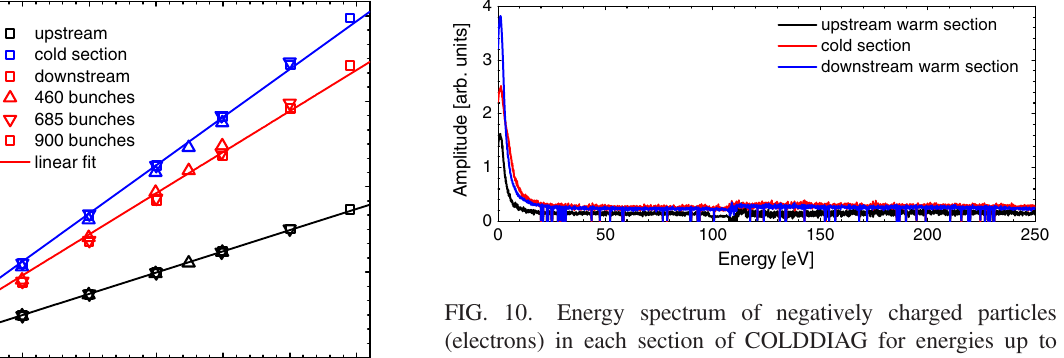
0 FIG. 9. Flux of negatively charged particles (electrons) as a function of beam current for three different beam current ramps in each of the three sections of COLDDIAG. Accuracy of the current measurement: (cid:2) 0 . 1% þ 0 . 1 nA [16].